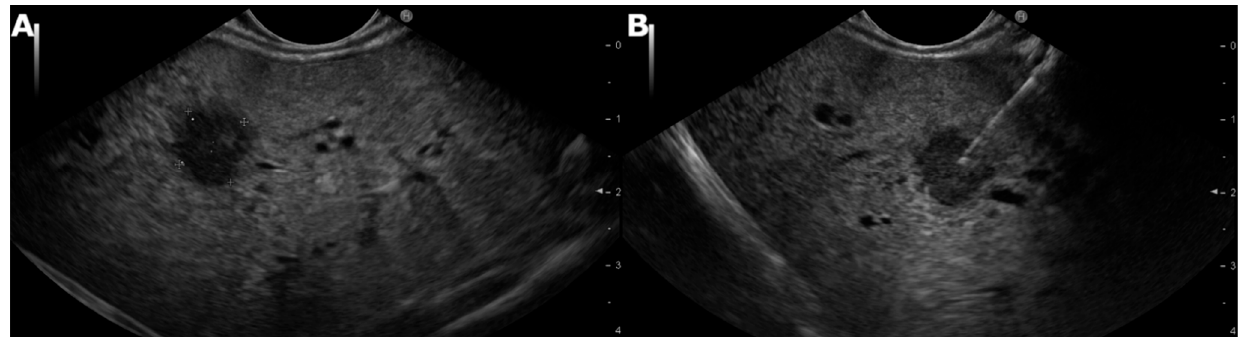
Figure 1. ( A ) Linear echoendoscope showing a focal lesion in the right lobe of the liver. ( B ) Linear echoendoscope showing fine-needle biopsy of the focal lesion in the right lobe of the liver.